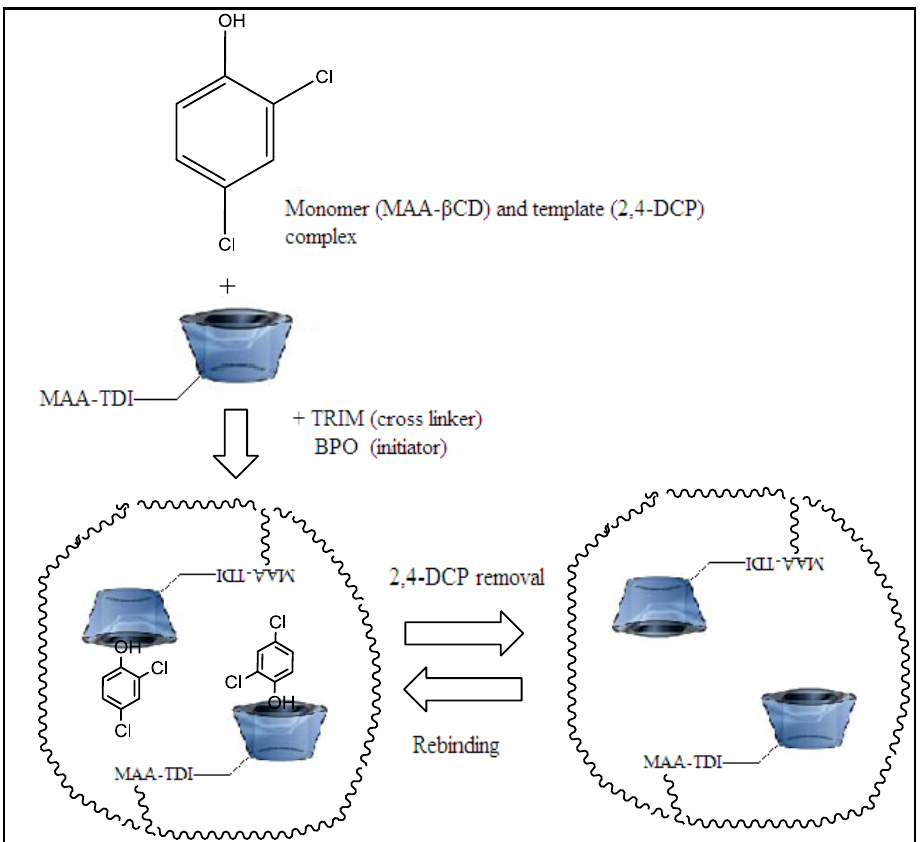
Figure 9. Molecular imprinting of MIP MAA-βCD using 2,4-DCP as